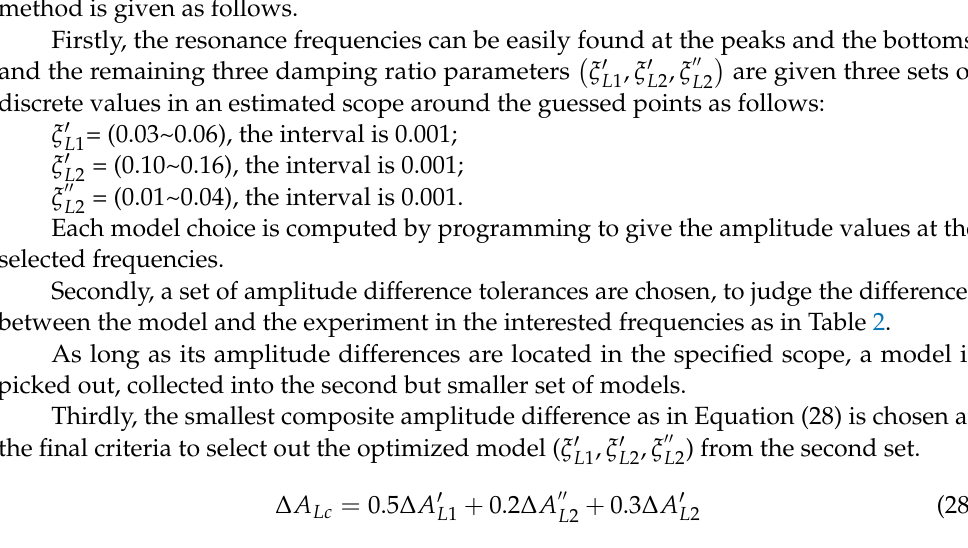
untested higher frequency